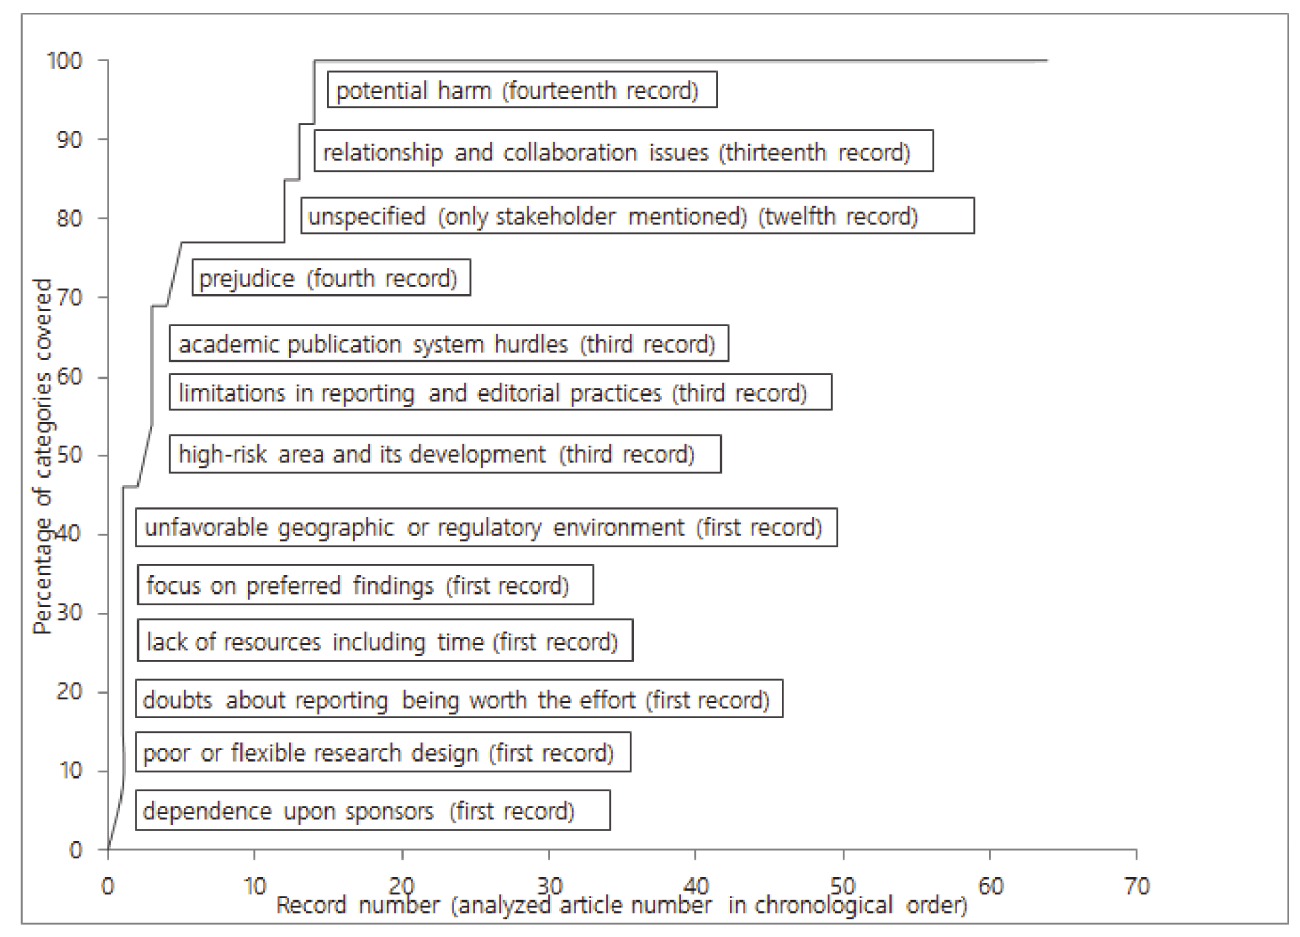
Fig 2. Saturation graph. The horizontal axis displays the articles (records) in chronological order of analysis. The vertical axis displays the percentage of the 12 (plus 1 unspecified) determinant categories containing at least one determinant. The labels describe which determinant category appeared for the first time in which